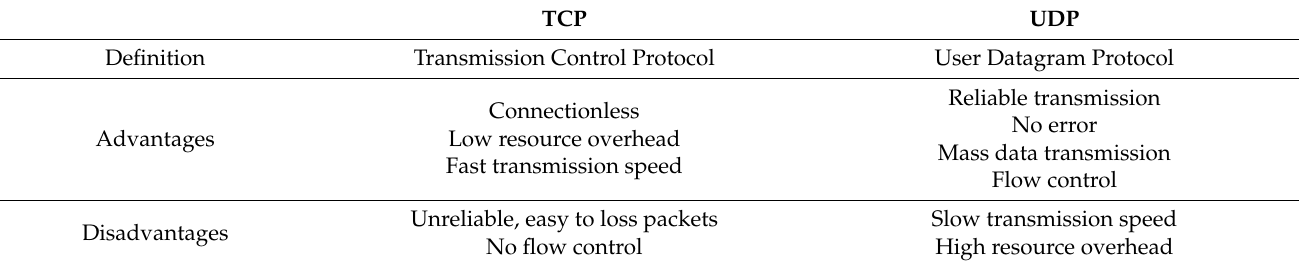
Table 3. Specification comparison between TCP and UDP.